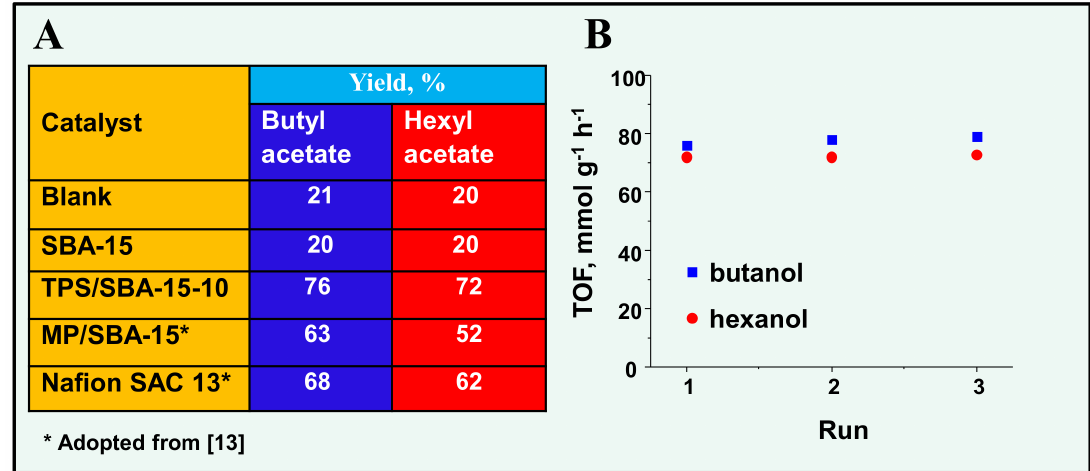
Figure 4. ( A ) Activity in the esterification of acetic acid with n-butanol and n-hexanol; ( B ) Stability and TOF (mmol of acetic acid reacted on 1 g of catalyst during 1 h) of TPS/SBA-15-10 in esterification